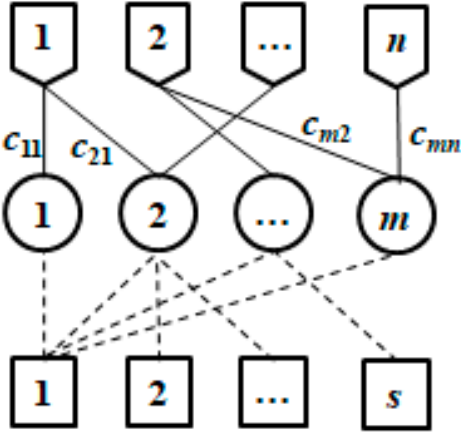
Figure 1. Distribution of tasks in MARTS.